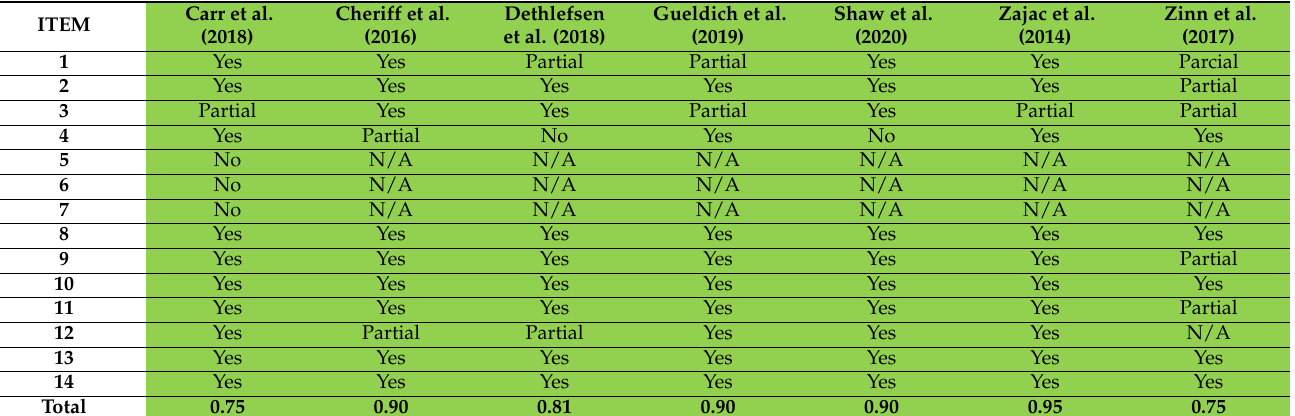
Table 5. Methodological assessment using the